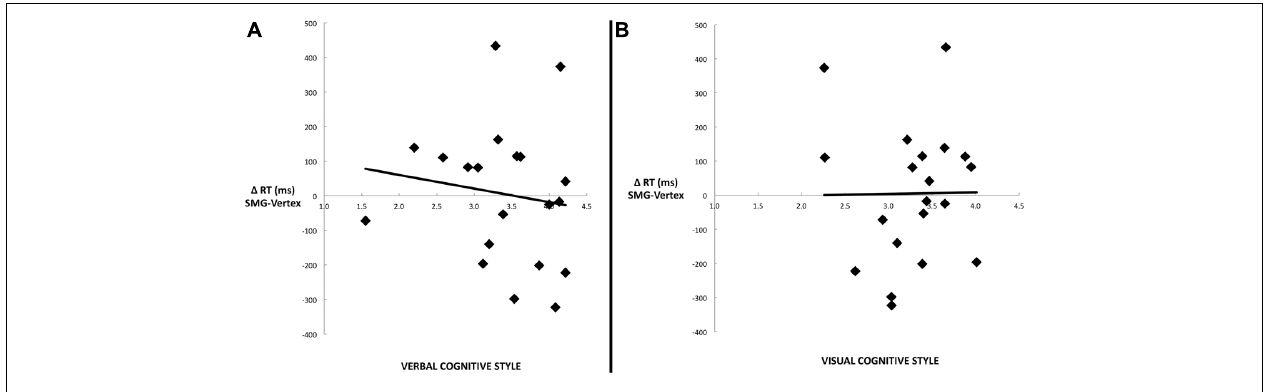
FIGURE 5 | Scatter plots depicting the lack of correlation between median response time differences (SMG–Vertex) for the picture–word condition as a result of left SMG rTMS and (A) the verbal cognitive style ( r = –0.14, p = 0.56), or (B) the visual cognitive style ( r = 0.01, p =